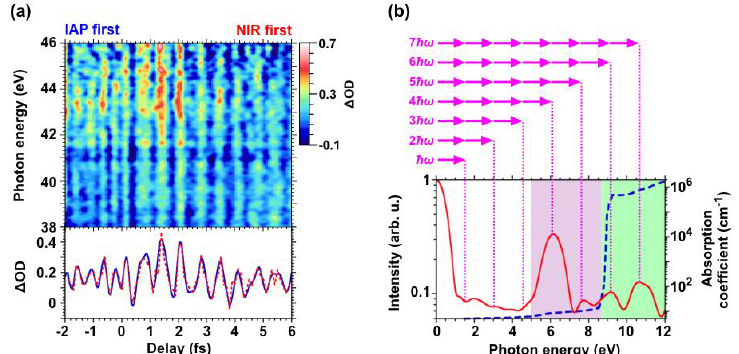
Fig. 2. FTXUV trace and energy component. (a) The transient absorption trace in Cr: Al 2 O 3 . The trace shows the deviation of optical density ( Δ OD) with and without the NIR pulse. The bottom trace shows the integrated line profiles (red dashed line) for the whole energy region in the upper graph. The blue solid line is the interpolation process line profile. (b) The line profile spectra (red solid line) after Fourier transformation for the temporal delay axis in (a). The pink dotted lines correspond to the photon energies of the NIR pulse. The ħω corresponds to ~1.6 eV. The blue dashed lines show the linear absorption coefficient of Cr:Al 2 O 3 . The purple and green shaded areas correspond to the intermediate and CB states,